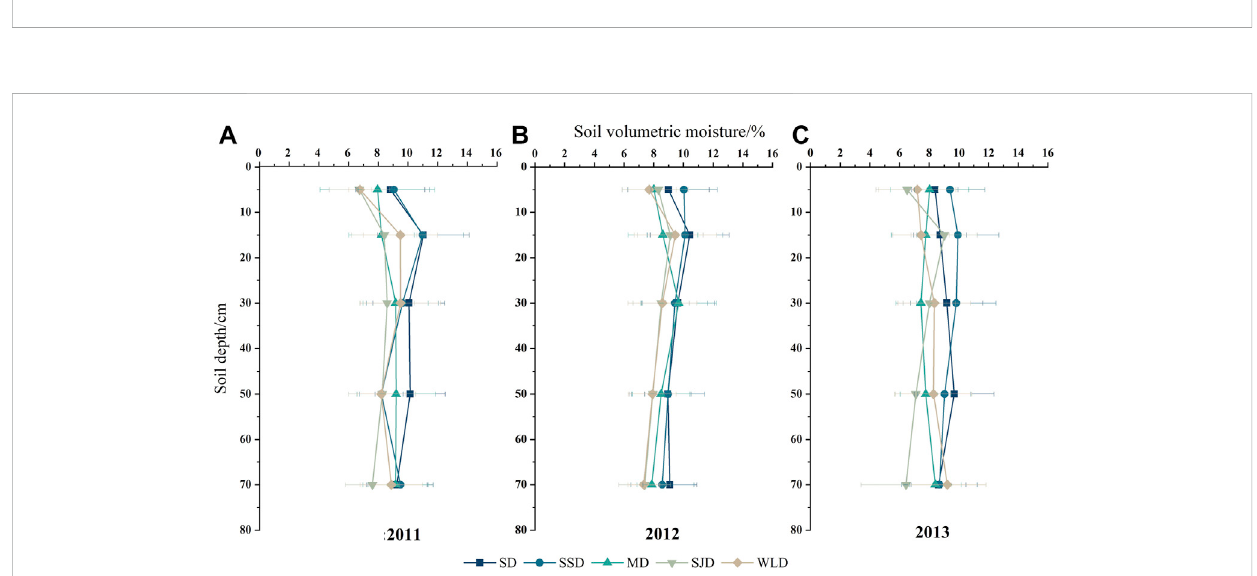
FIGURE 6 Vertical soil moisture variation 80 cm below the surface between 2011 and 2013 in different